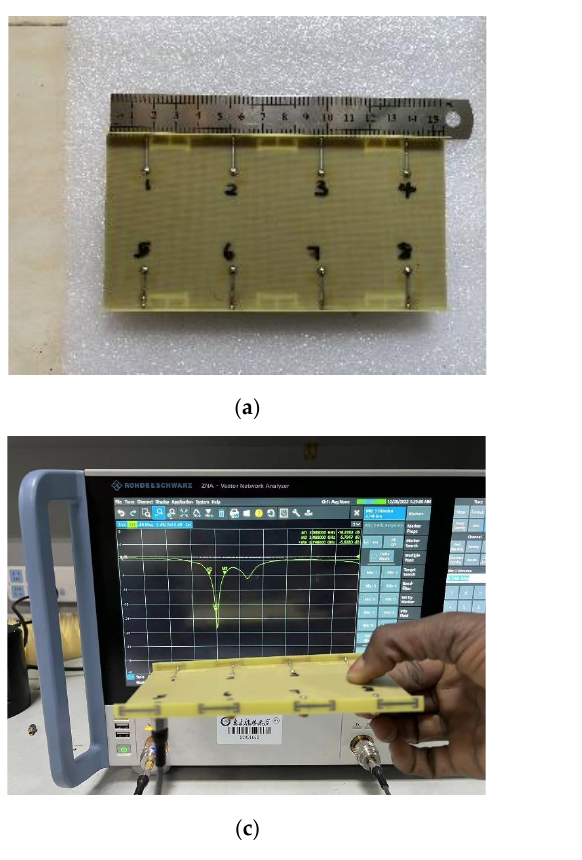
Figure 10. ( a ) Proposed MIMO system fabricated prototype ( b ) measurement set-up ( c ) S-parameter measurement by the VNA ( d ) antenna under measurement in the chamber room.